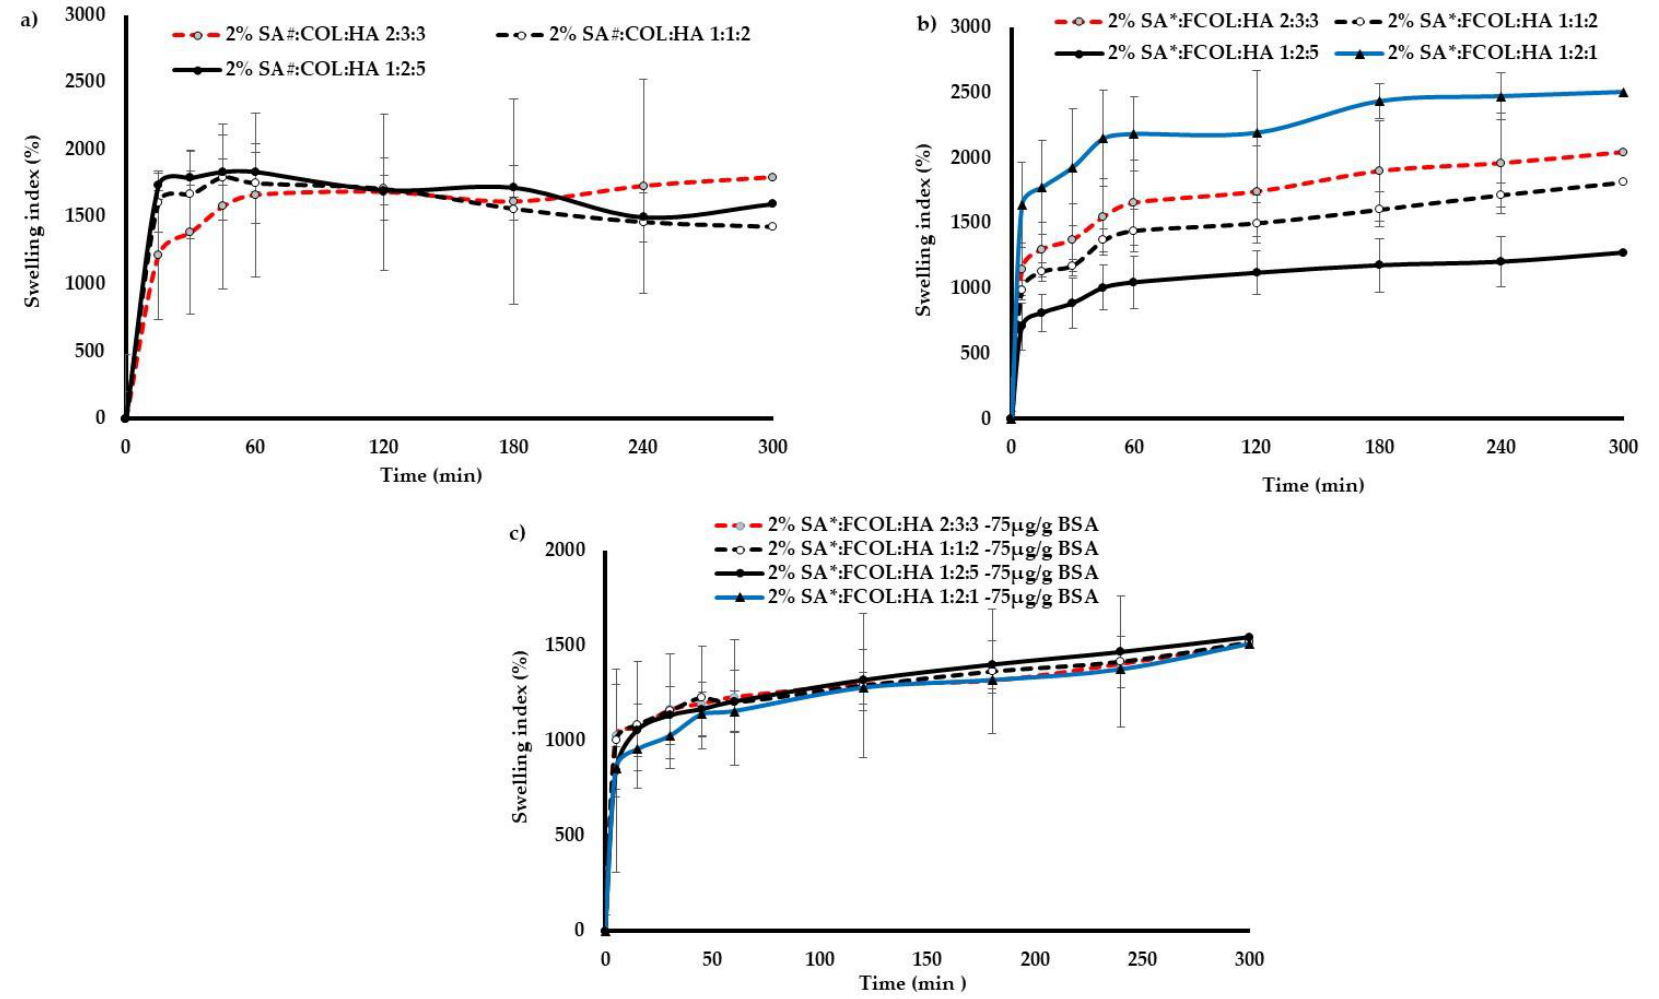
Figure 7. Shows swelling profile of ( a ) SA#, FCOL and HA; ( b ) SA*, FCOL and HA; ( c ) BSA loaded scaffolds in SWF, pH 7.4 ( n = 3).